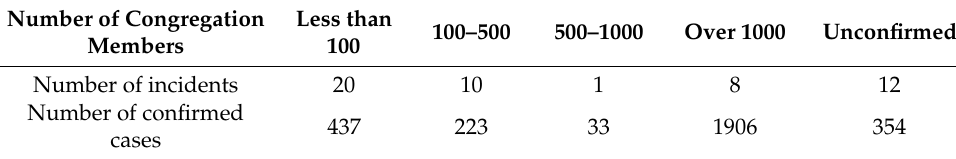
Table 6. Cluster cases from Protestant churches categorized by church